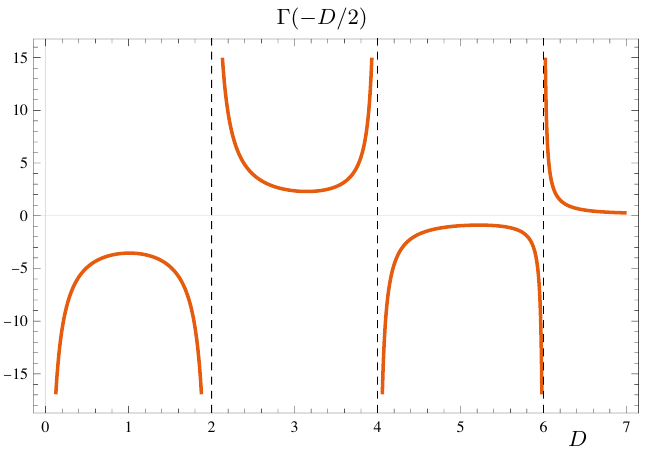
Figure 1 . The leading term in the grand potential on the torus ∝ Γ( − D/ 2) for 0 < D < 7 . The function is positive for 2 < D < 4 , 6 < D < 8 ,